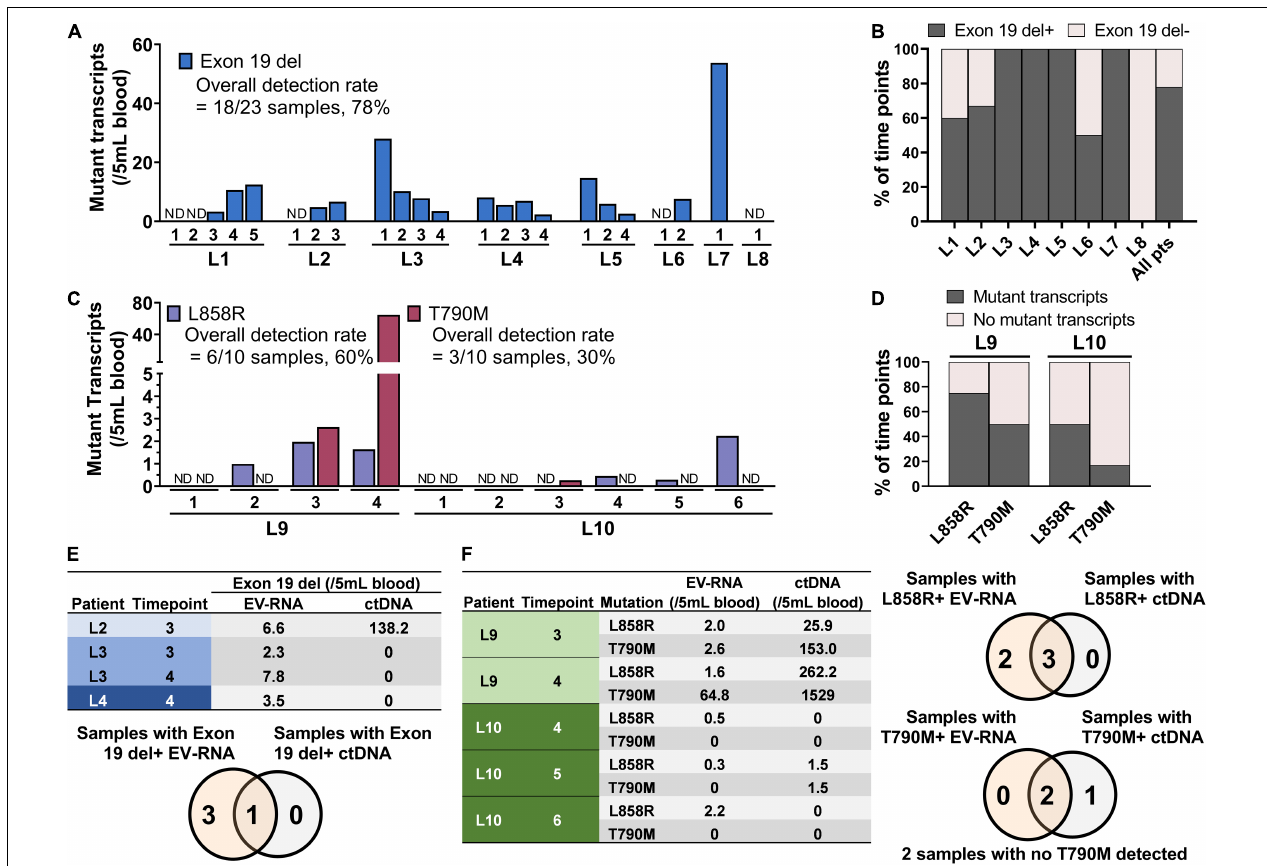
FIGURE 3 | Detection of EGFR mutations in EV-RNA samples from metastatic NSCLC patients. (A) EGFR exon 19 del transcript concentration per time point for the eight patients pre-identified as being exon 19 del positive. (B) Percent of time points that tested positive for EGFR exon 19 del mutations per patient. (C) Mutant EV-RNA concentration for both L858R and T790M mutations across time points for two patients. (D) Percent of time points that tested positive for L858R and T790M mutations by patient. (E,F) Comparative concentration of EGFR mutations found in ctDNA and EV-RNA along with Venn diagrams displaying the overlap in samples with detected mutations in EV-RNA and ctDNA for (E) four samples with known exon 19 del mutations and (F) five samples with known L858R and T790M